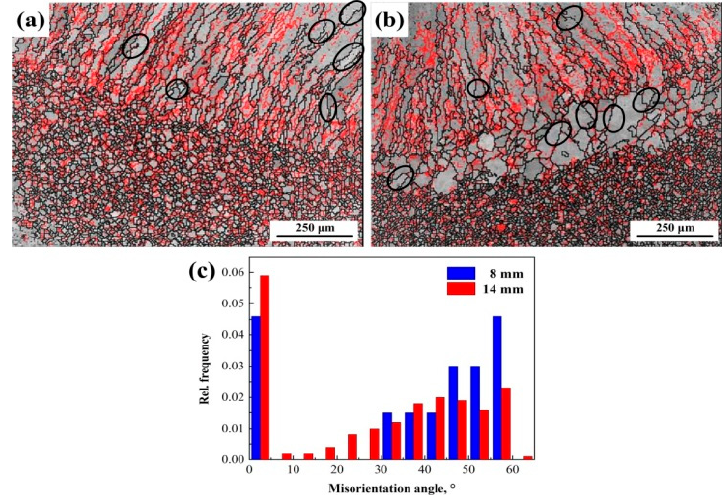
Figure 8. Grain boundary maps for the ( a ) 1670-8, ( b ) 1670-14, and ( c ) the relative frequency of misorientation angle.